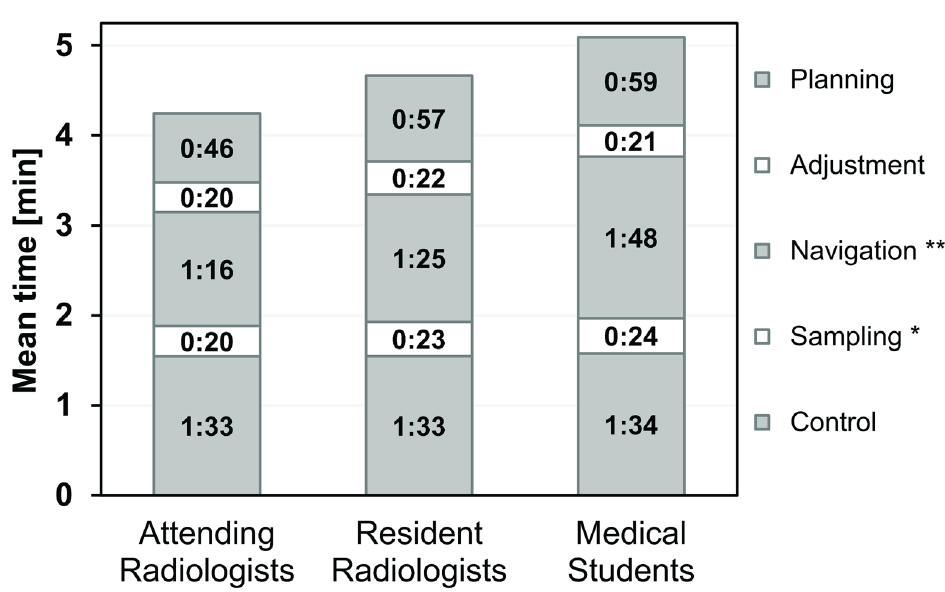
Fig 6. Contribution of five working steps (planning, adjustment, navigation, sampling and control) to the mean experimental biopsy time for each operator group (AR, RR, MS). The times stated are averages of 80 individual measurements from 8 operators on 10 targets each. Navigation times ranged between 01:16 (AR) and 01:48 (MS) and differences between operator groups were significant (ANOVA p < 0.01, ** ). Sampling times ranged between 00:20 (AR) and 00:24 (MS) and between-group differences were significant (p < 0.05, * ). All other working step times were not significantly different (see text for details).